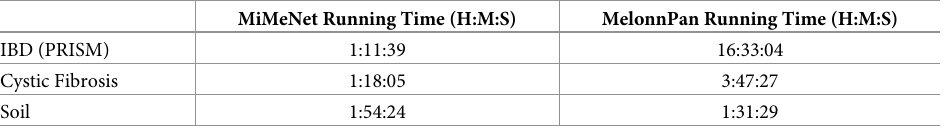
Table 2. Running time for MiMeNet and MelonnPan. Running time for MiMeNet was calculated using the recom- mended settings from the Github page: 20 random searches for hyper-parameter tuning, 10-iterations of 10-fold cross- validation for prediction evaluation, 10-iterations of 10-fold cross-validation for background generation, and the train- ing of 10 final candidate models. MelonnPan was run using 10-iterations of 10-fold cross-validation and for the IBD (PRISM) dataset MelonnPan only used the 466 annotated metabolomic